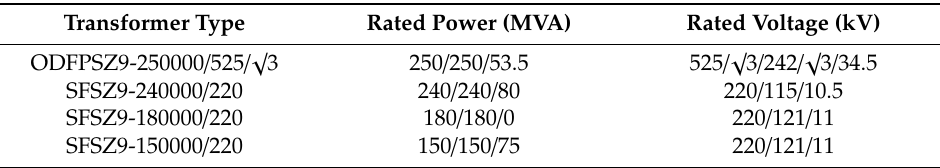
Table 1. Characteristic rules of normal